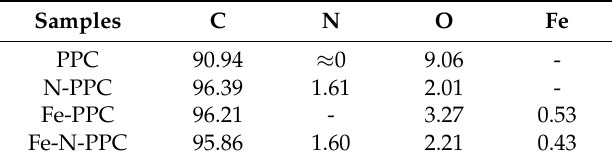
Table 1. Atomic contents of the samples by X-ray photoelectron spectroscopy (XPS).